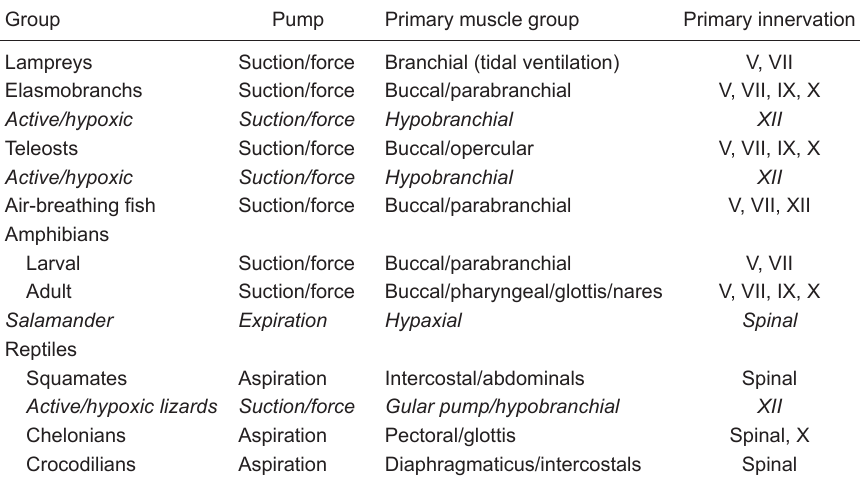
Table 1. Respiratory pumps and their